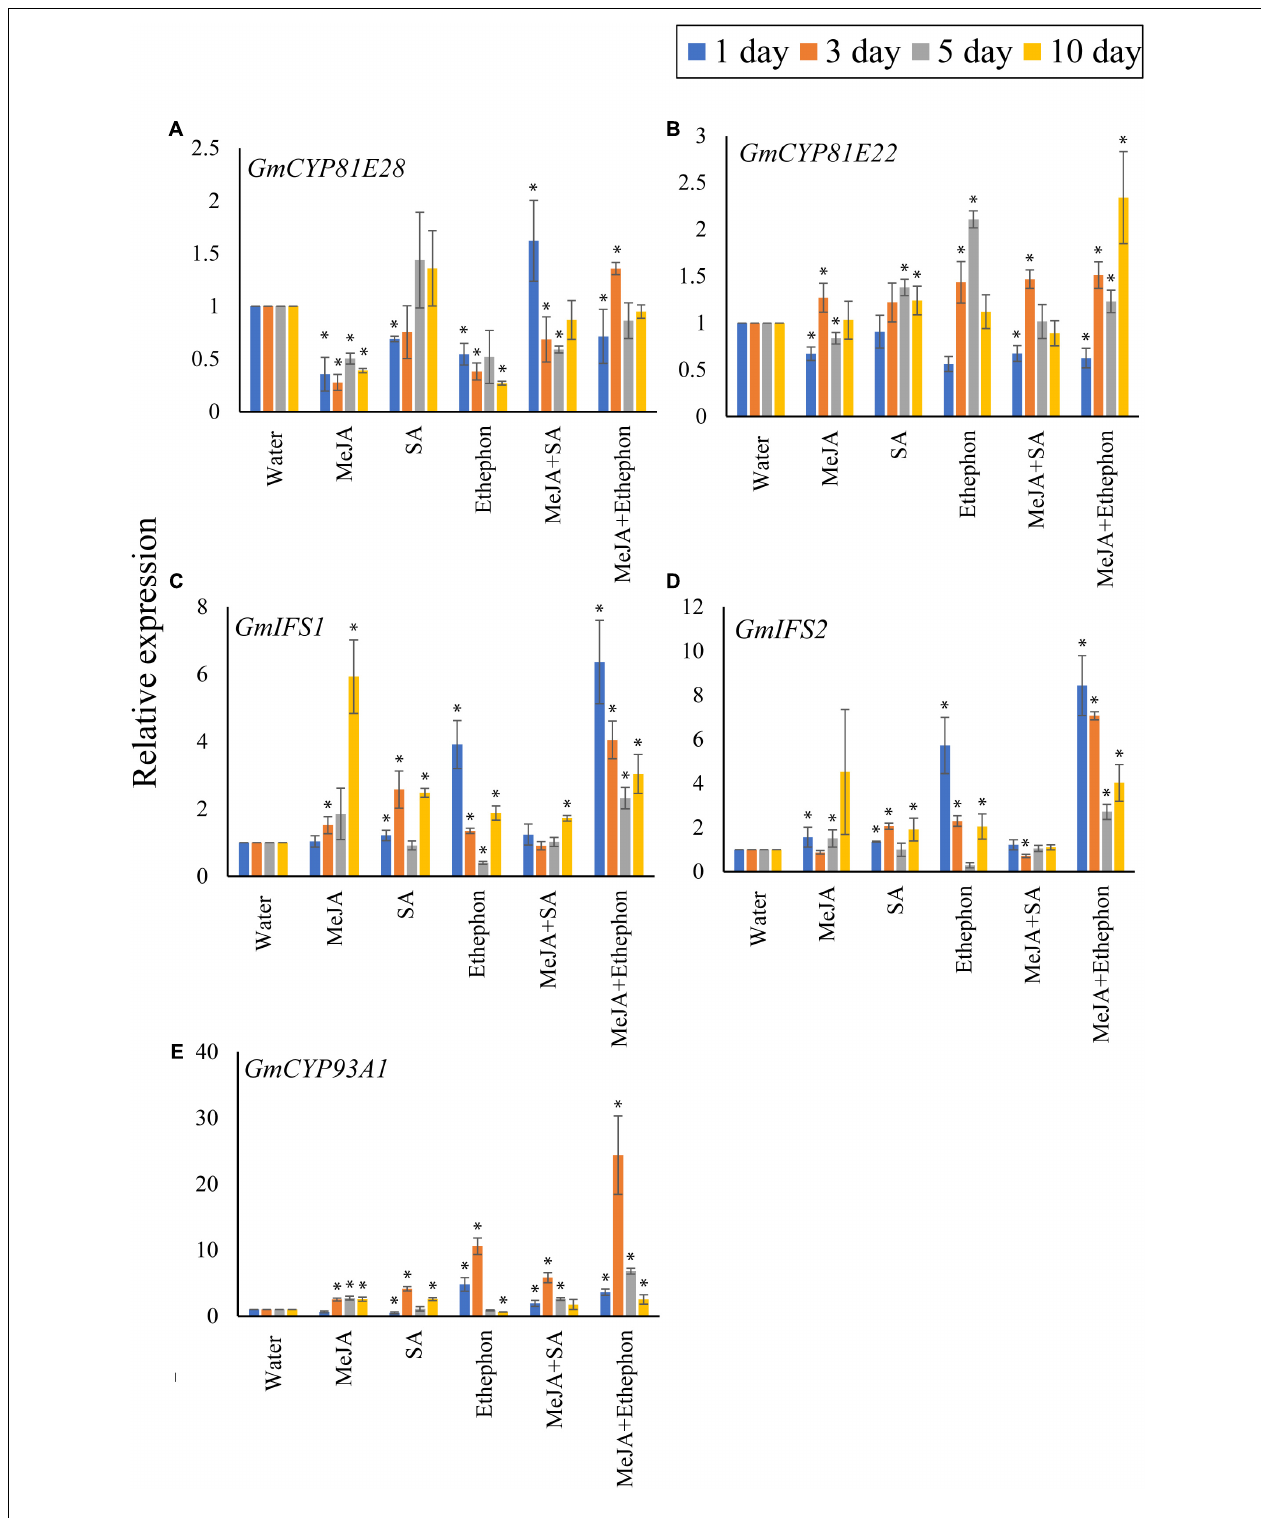
FIGURE 5 | Real-time PCR analysis. Expression analysis of the coumestrol biosynthesis pathway genes. Five genes, (A) GmCYP81E28 , (B) GmCYP81E22 , (C) GmIFS1 , (D) GmIFS2 , (E) GmCYP93A1 were checked. All data points represent the mean of three replicates. Error bars indicate standard error. Asterisks (*) indicate a significant difference between the means of the treatments and the corresponding control (water). Means with significant differences were separated using the Student’s T -test at 0.05% level of significance.